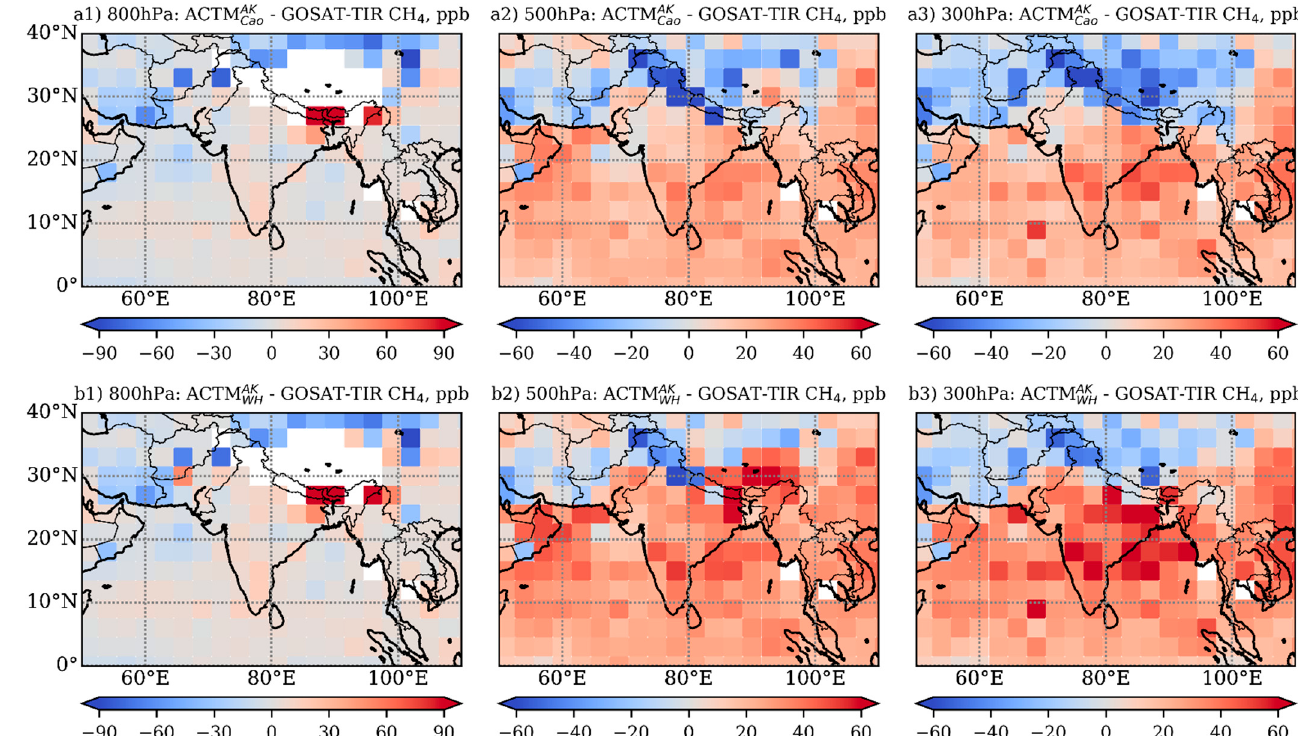
Figure 7. Latitude–longitude difference in CH 4 distributions simulated by MIROC4-ACTM and observed by GOSAT-TIR at the levels of 800, 500, and 300 hPa (the left, middle, and right panels, respectively) for JAS 2011. The top row ( a1 – a3 ) and bottom row ( b1 – b3 ) show the difference in CH 4 between GOSAT-TIR, and ACTM Cao and ACTM WH ,